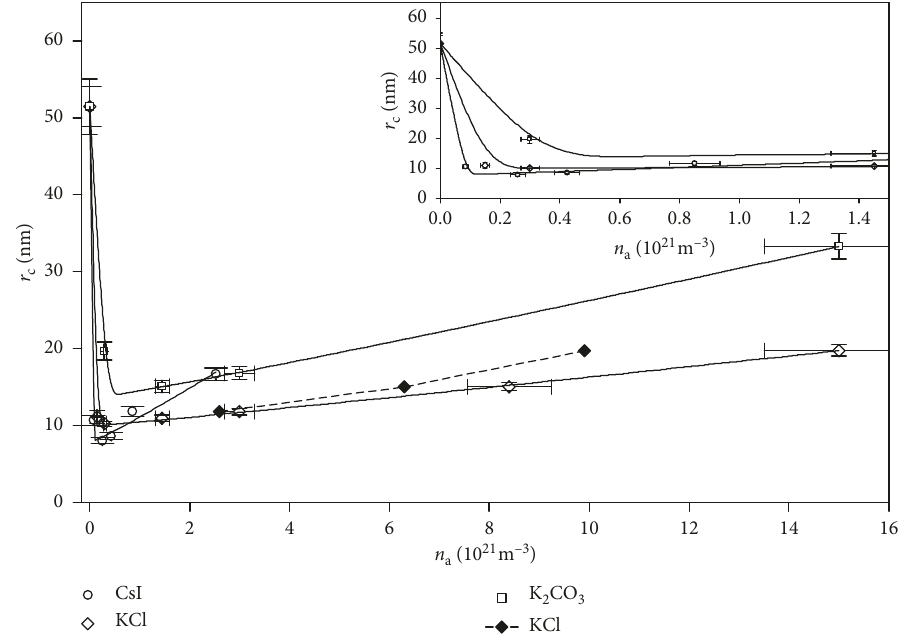
Figure 1: Dependence of the average radius of Al